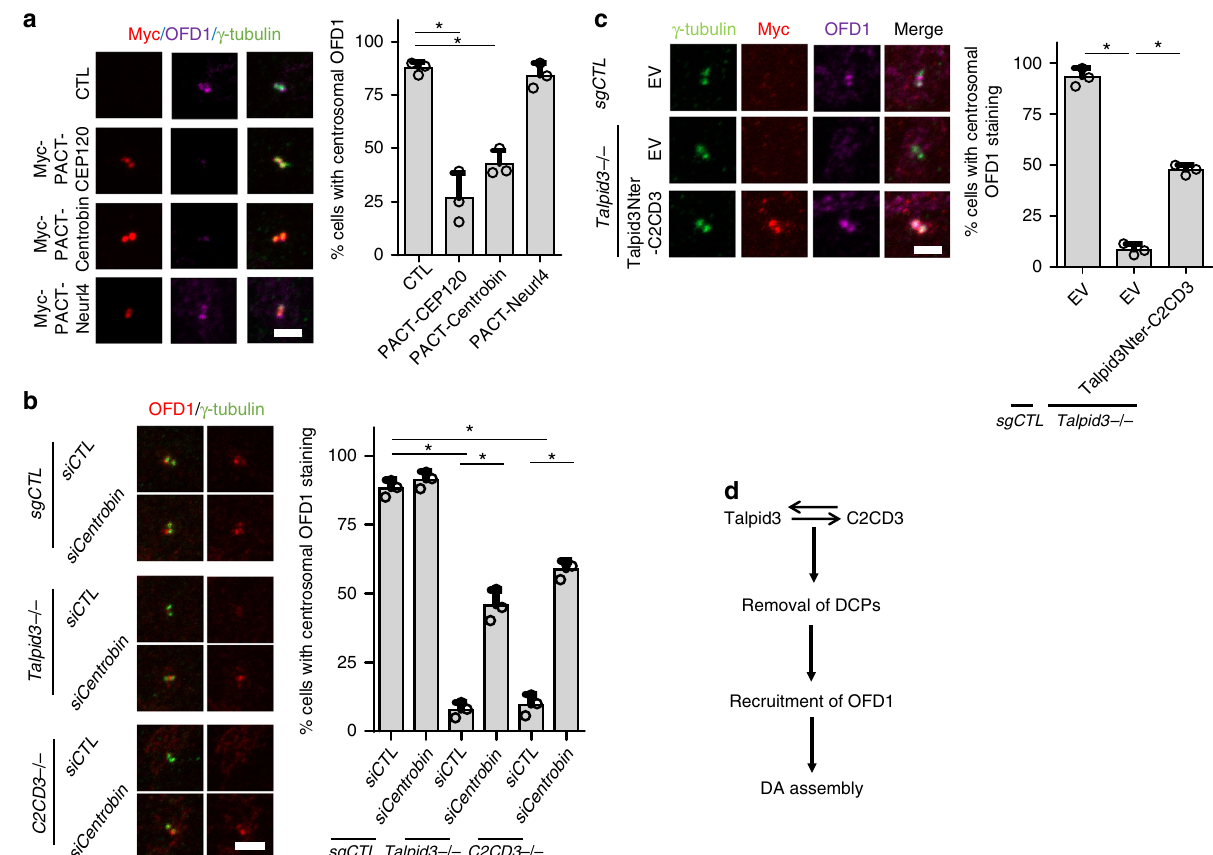
Fig. 5 Asymmetric localization of DC-enriched proteins is required for proper localization of OFD1. a WT RPE1 cells were transduced with lentiviruses expressing Myc-PACT – CEP120, Myc-PACT – Centrobin, or Myc-PACT-Neurl4, as indicated. Two days after transduction, cells were serum-starved for 48h and examined by IF with indicated antibodies. b Control, C2CD3 − / − , and Talpid3 − / − cells were transfected with siRNAs against Centrobin. Two days after transfection, cells were serum-starved for 24h and were visualized with indicated antibodies. c OFD1 recruitment defect in Talpid3 − / − cells was rescued by infection with lentiviruses expressing the Talpid3 – C2CD3 fusion protein described in Fig. 3e. Cells were examined by IF after 48h of serum starvation using indicated antibodies. d Model indicating a centriole maturation regulatory mechanism. Cumulative data from three independent experiments are shown. For each group, a minimum of 100 cells/experiment was averaged. All data are presented as mean ± SD. * p < 0.05 (unpaired t -test). Scale bars = 2 μ